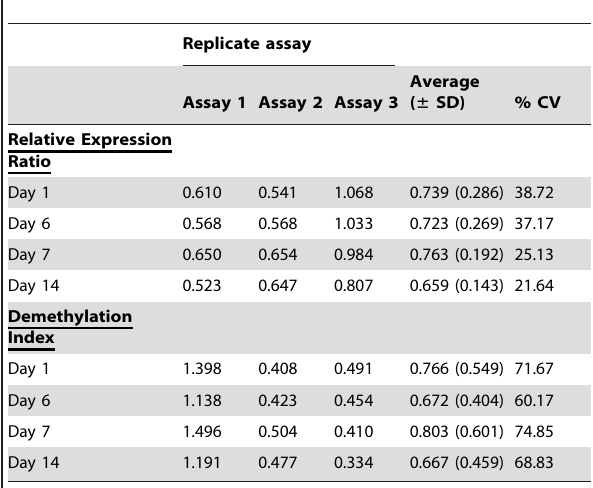
Table 5. Inter-assay reproducibility of the qMSP